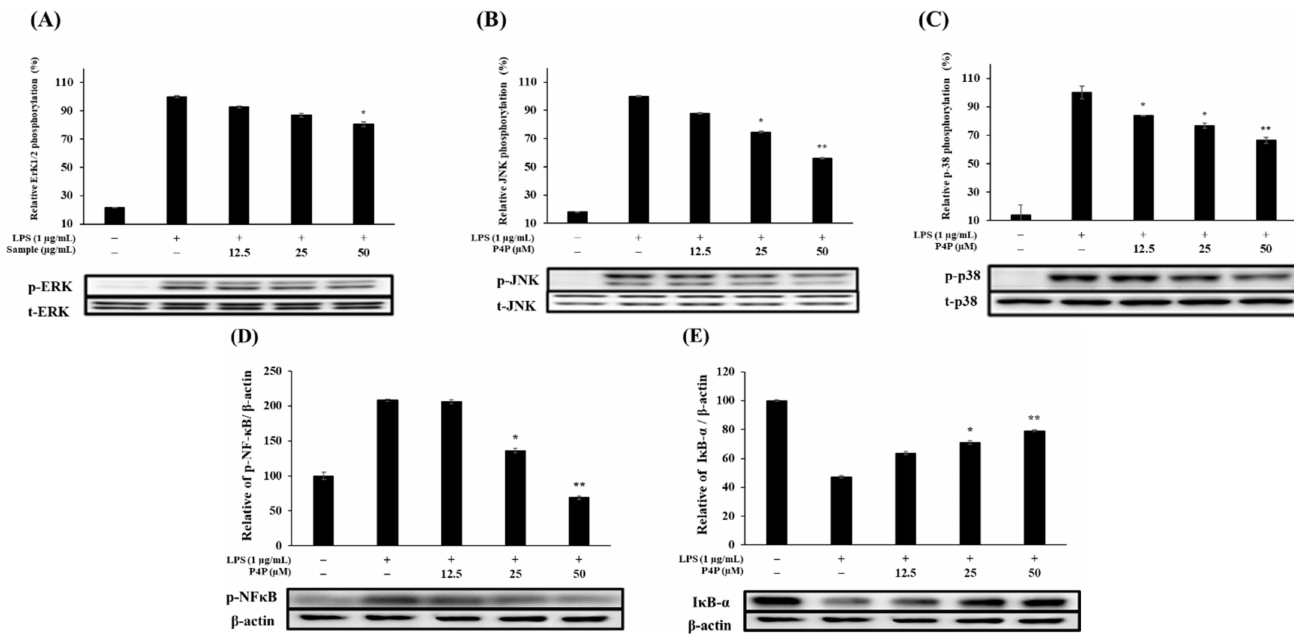
Figure 5. Effects of P4P on mitogen-activated proteins, including ( A ) ERK, ( B ) JNK, ( C ) p38, ( D ) NF κ B, and ( E ) I κ B-kinase activation. Cells were stimulated with LPS (1 µ g/mL) in the presence (12.5, 25, or 50 µ M) or absence of P4P (0.01% DMSO) for 40 min. the expression levels of MAPK, NF κ B, I κ B, and β -actin protein were measured. * p < 0.05, ** p < 0.01 versus LPS